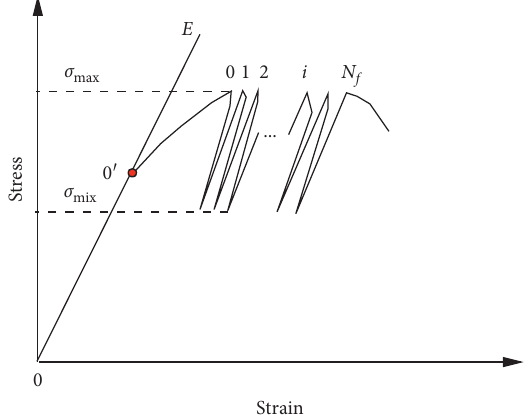
Figure 2: Schematic diagram of fatigue test.